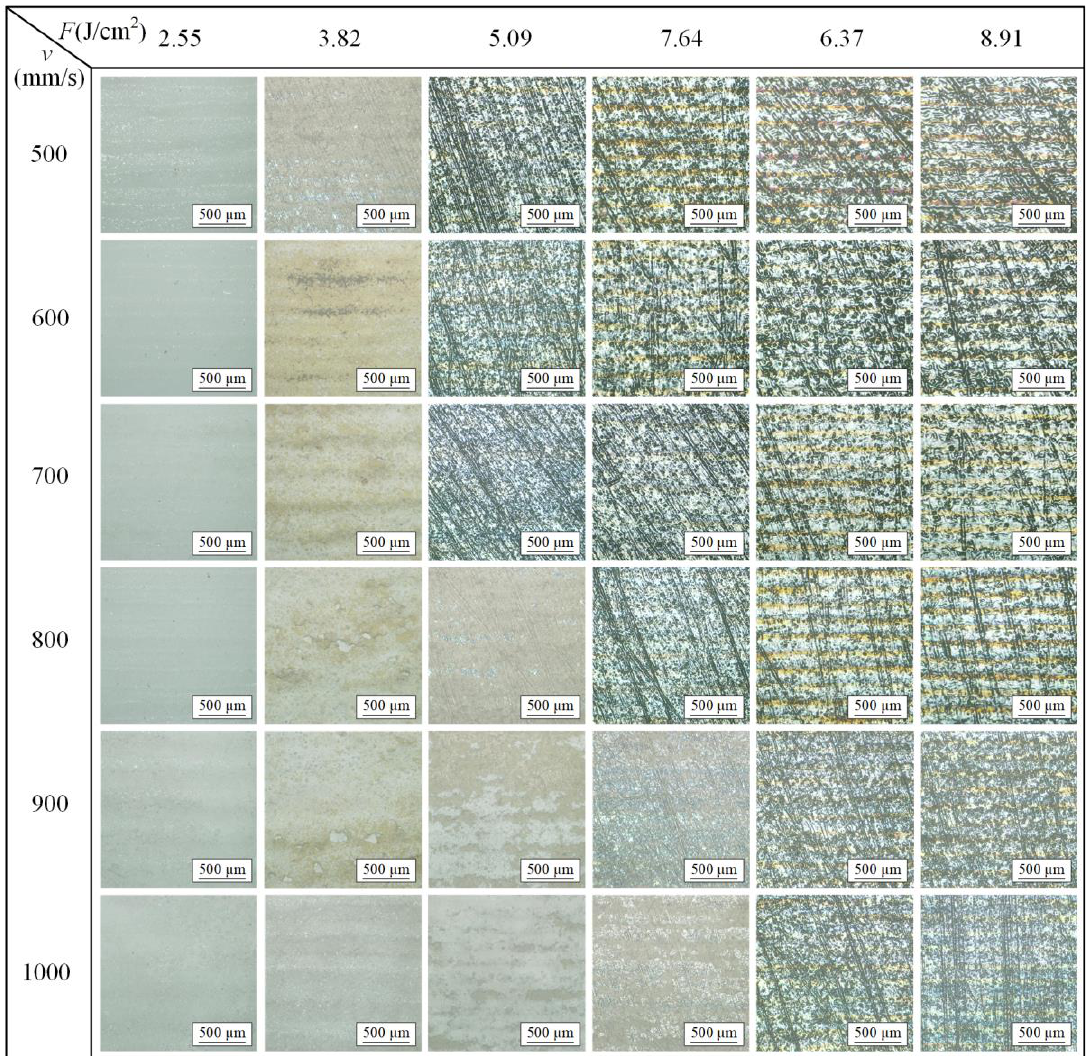
Figure 3. Macro morphology of aircraft skin surfaces after laser cleaning with different laser fluences and scanning